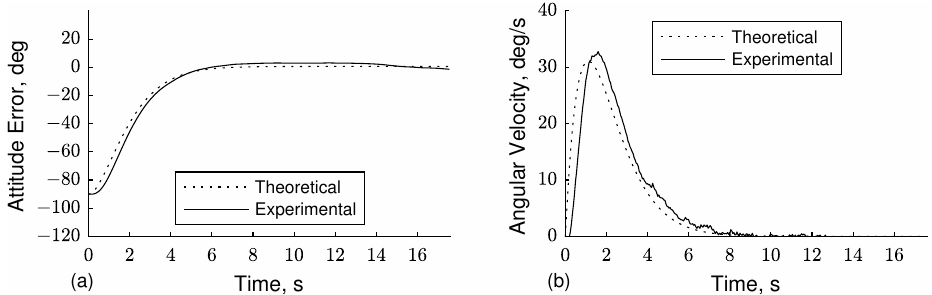
Figure 12. ( a ) Attitude error and ( b ) angular velocity of the platform for 90 deg maneuver.